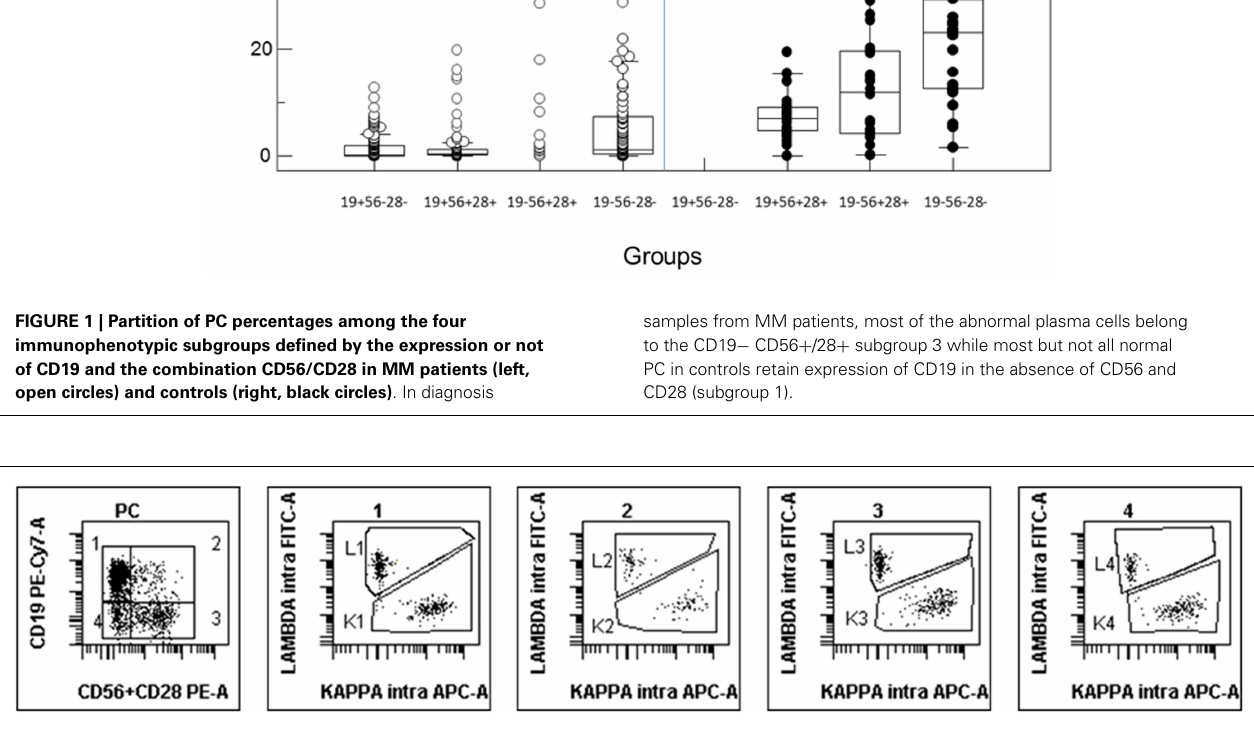
FIGURE 2 | Example of FCM scattergrams of a control BM sample . The left panel shows the partition in four subgroups of CD38 + /CD138 + cells (initial gate, not shown) according to the expression or not of CD19 and the combination of CD56/CD28. Most of normal PC are in